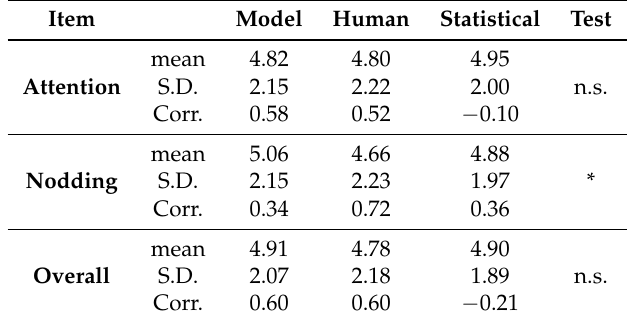
Table 10. Summary of the results of subjective evaluation (* : p < 0.05, n.s. : not significant). Item Model